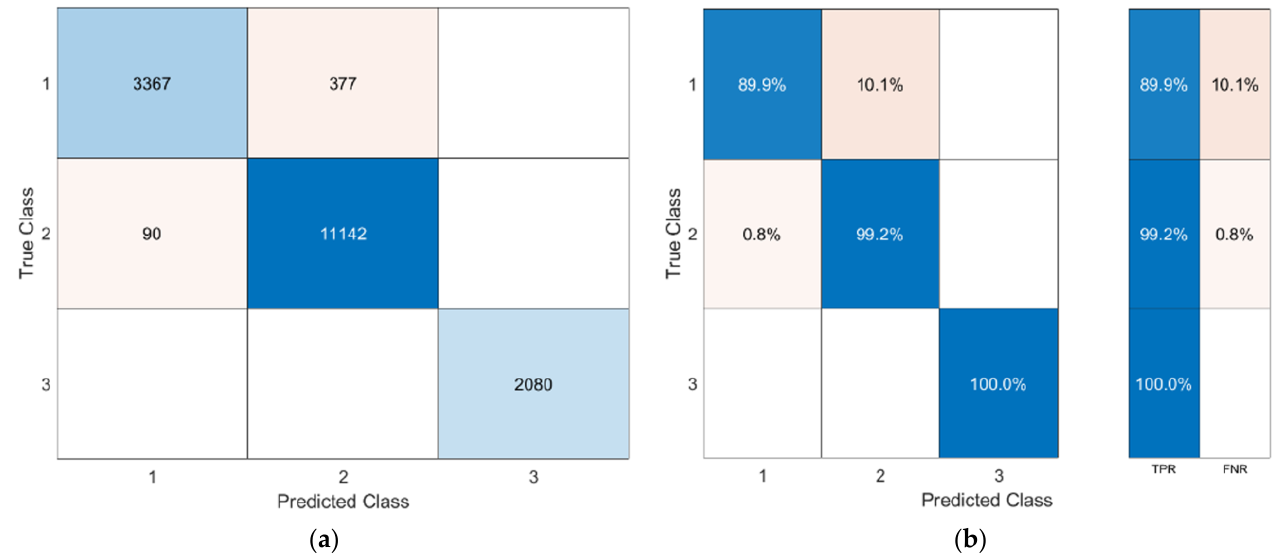
Table 7. Performance of fault detection using SFS with SVM (five-fold cross-validation).